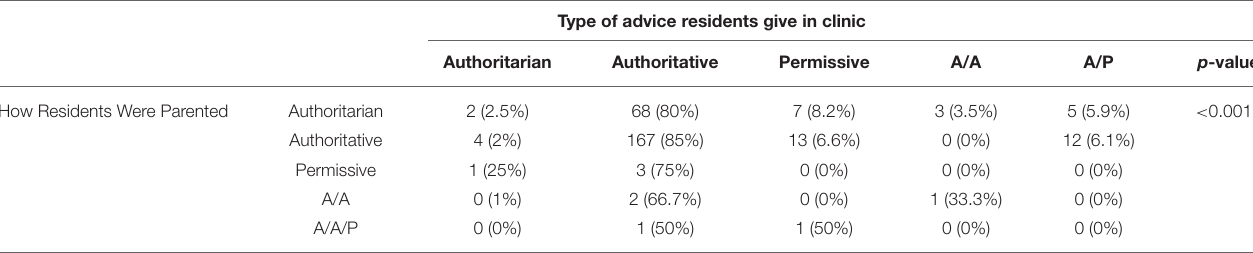
TABLE 4 | Analysis of how residents were parented in childhood and the type of parenting advice they give in clinic based on resident parenting questionnaire sample ( N = 290) a